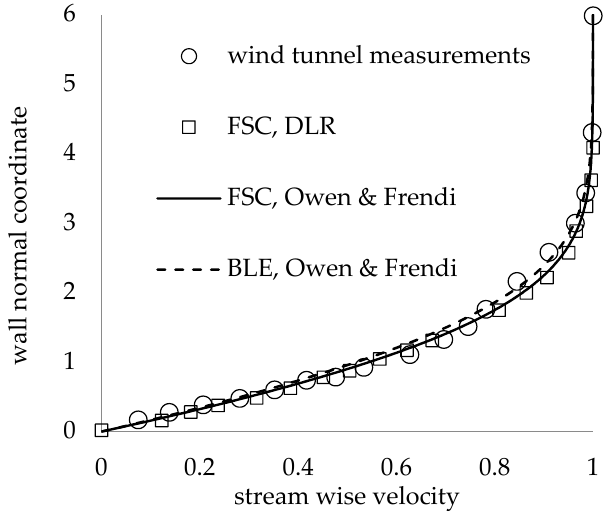
Figure 3. Velocity profiles in the streamline direction at 80% chord.